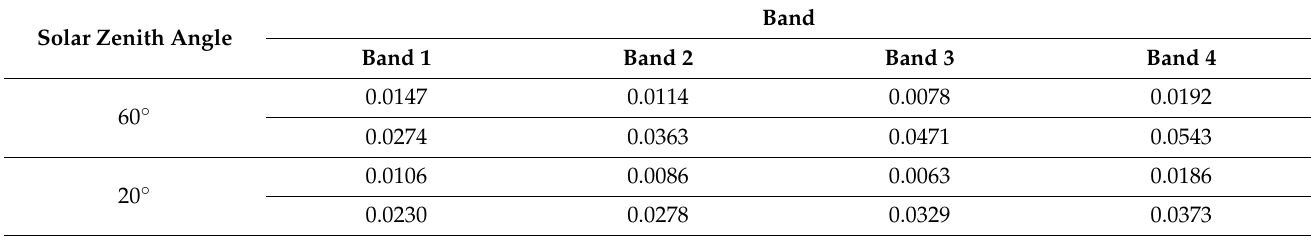
Table 8. RMSE of reflectance retrieval for dark surfaces (upper numbers) and bright surfaces (lower numbers) in the MZ spectral channels with an error 5% of radiometric calibration in these channels.